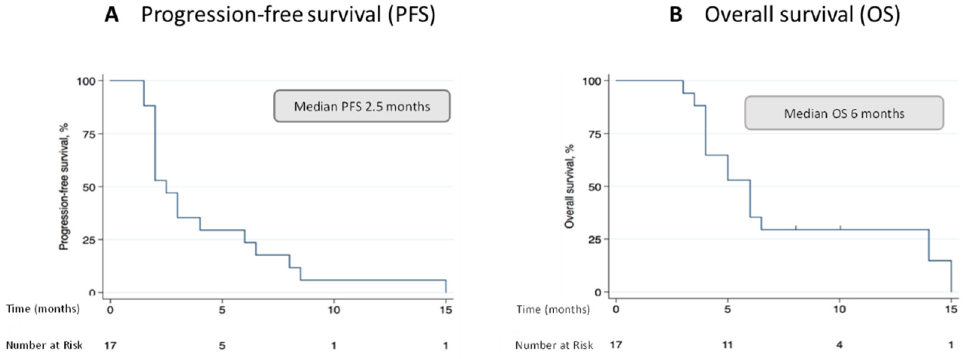
Figure 1. Kaplan–Meier curves showing progression-free survival ( A ) and overall survival ( B ) of mCRPC patients who received TIP therapy. Patients were treated at the University Cancer Center Hamburg-Eppendorf (UCCH). The data were analyzed retrospectively.